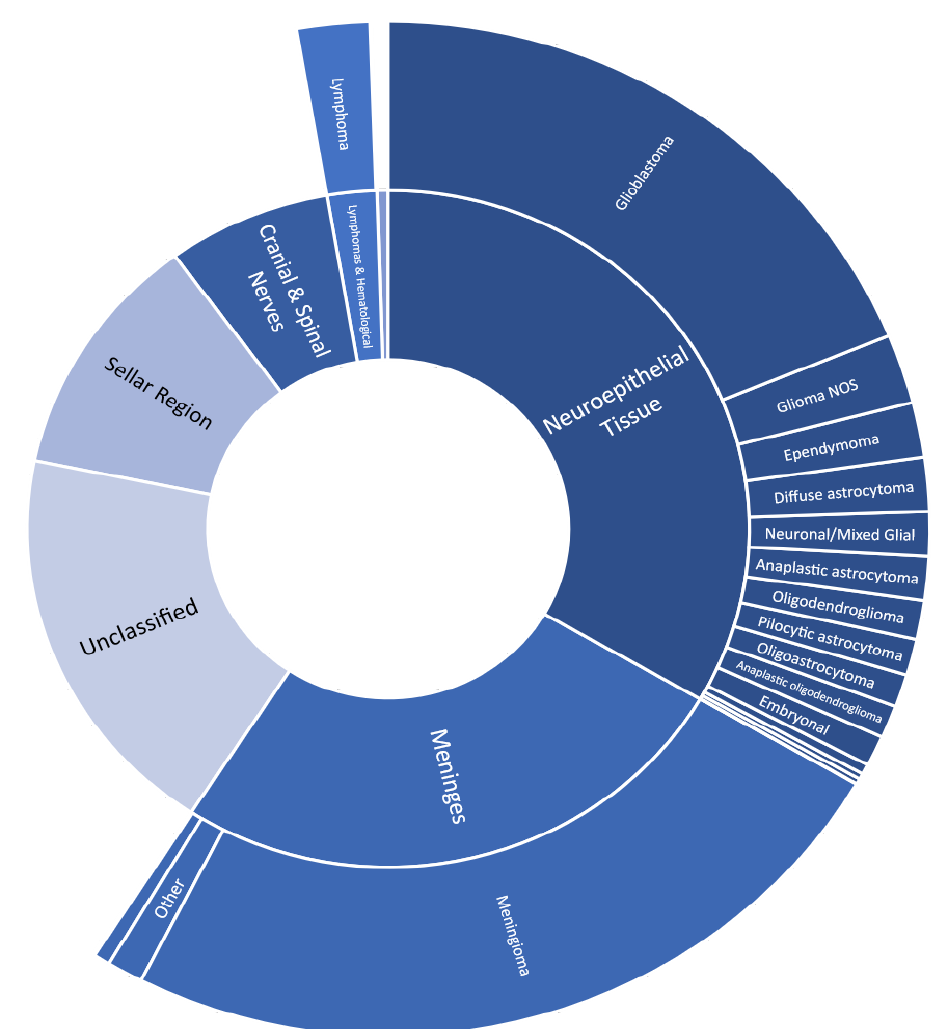
Figure 2. Distribution of all primary CNS tumours diagnosed among Canadians by major histology group (inner circle) and minor histology groupings (outer